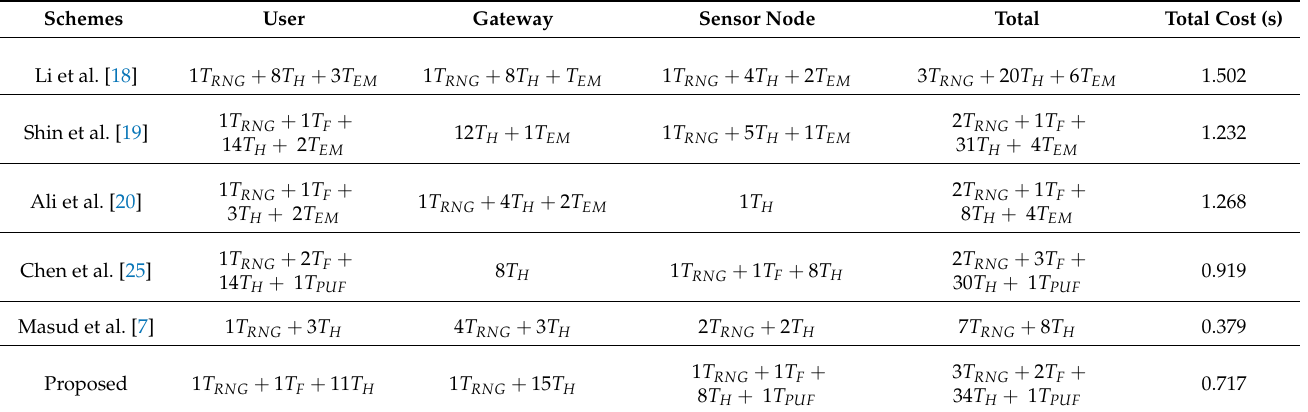
Table 5. Comparison of computational costs.